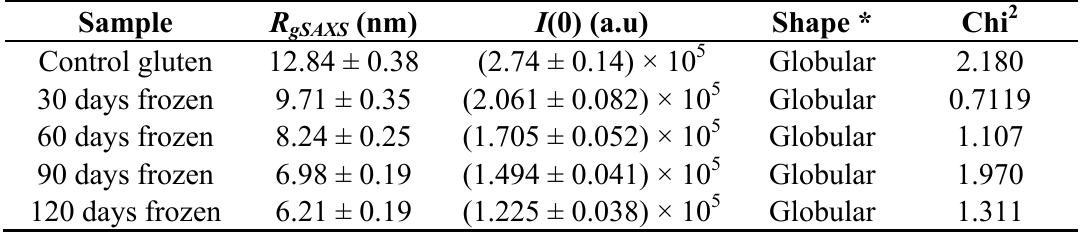
Table 1. Structural parameters obtained from the SAXS data of different frozen time gluten.